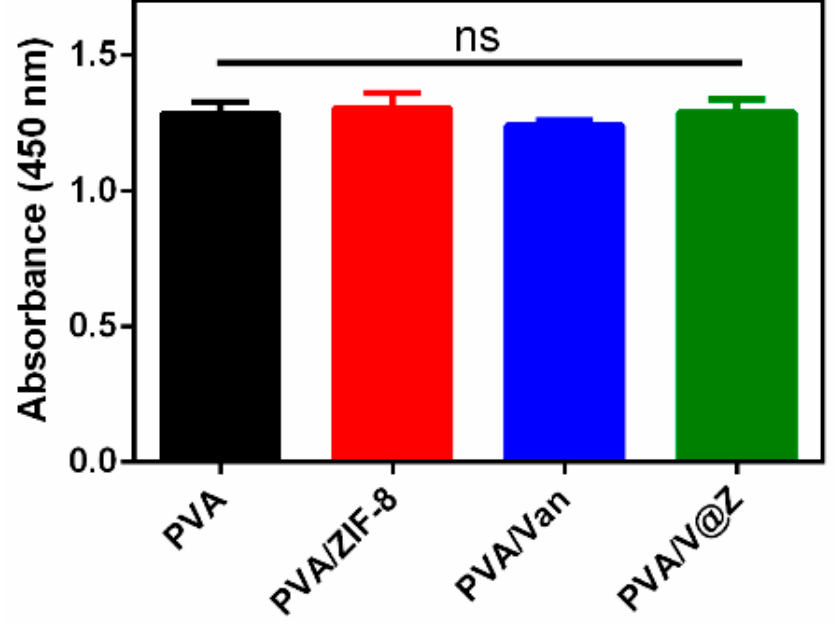
Figure 6. CCK-8 results of MC3T3-E1 cells after 24 h co-culture with different membranes (n = 5). (ns, not significant)